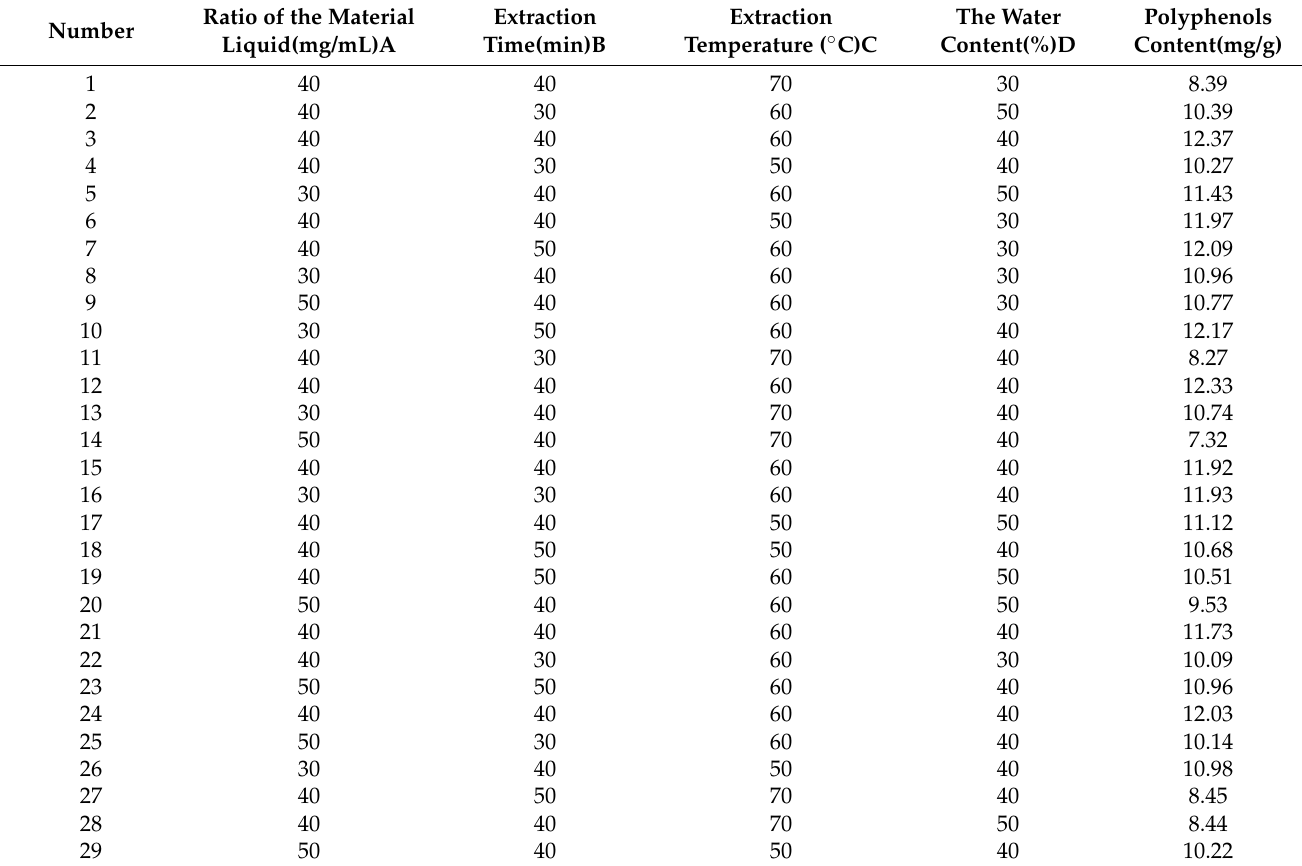
Table 1. Response surface experimental design scheme and results.